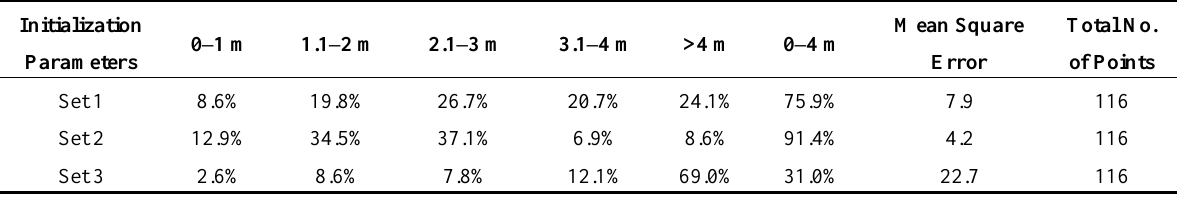
Table 4. Results of varied initialization parameters for the 3-AP I_J_K combination. Initialization